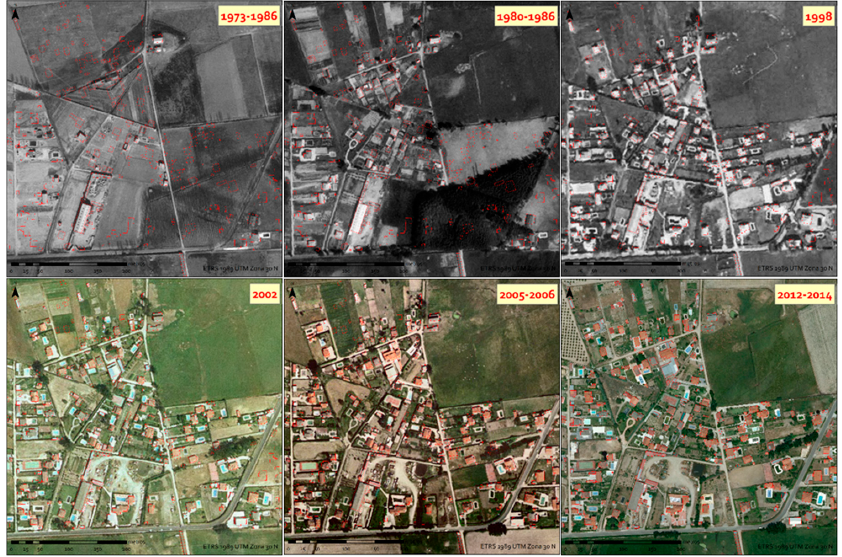
Figure 4. Mosaic of used sweeps.